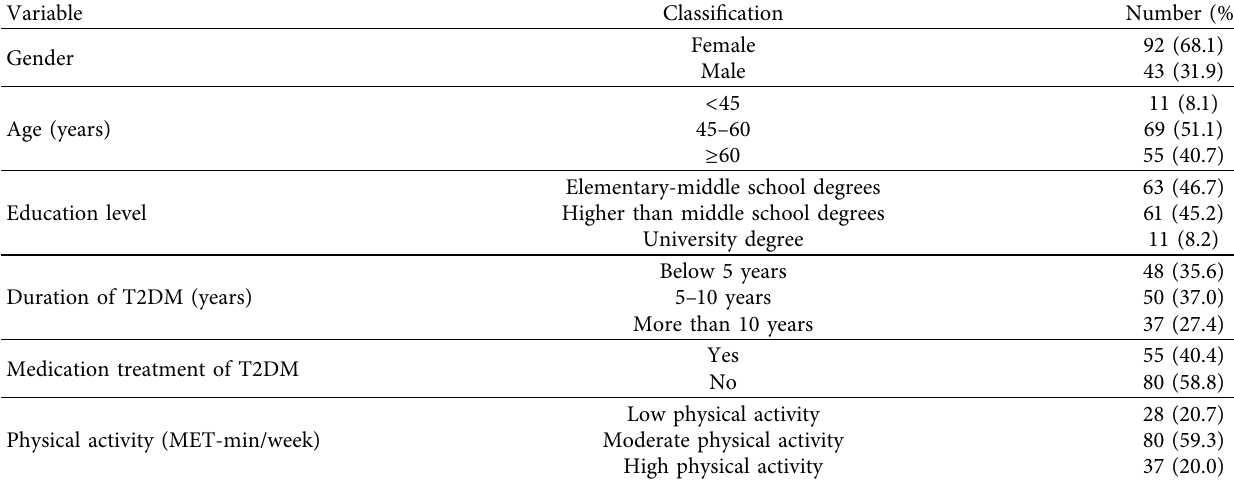
Table 1: Demographic characteristics and physical activity level of the participants ( N � 135).